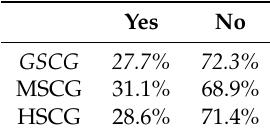
Table 2. Do you store personal passwords on your mobile device? (in plaintext).